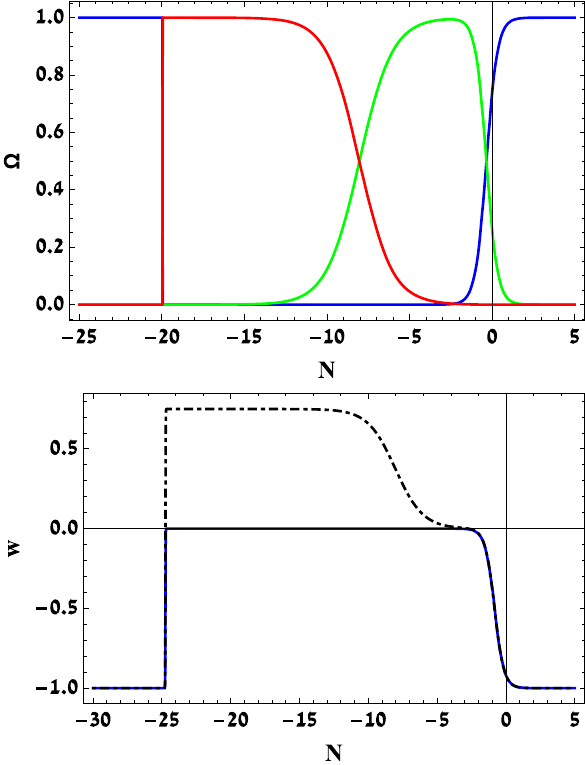
Fig. 4 The evolution of the energy densities for Ω m = 0 . 3089, Ω Λ = 0 . 691, ξ = 129, Γ = 0 . 1. The center of the Lorentzian is around N = − 20. Shortly after this point the radiation is created. The blue line is the energy density of the quintessential inflation. The red line is the energy density of the radiation, and the green line is for matter. In the lower panel the blue line describes the evolution of the scalar-field equation of states, and the blue dashed line is the total one